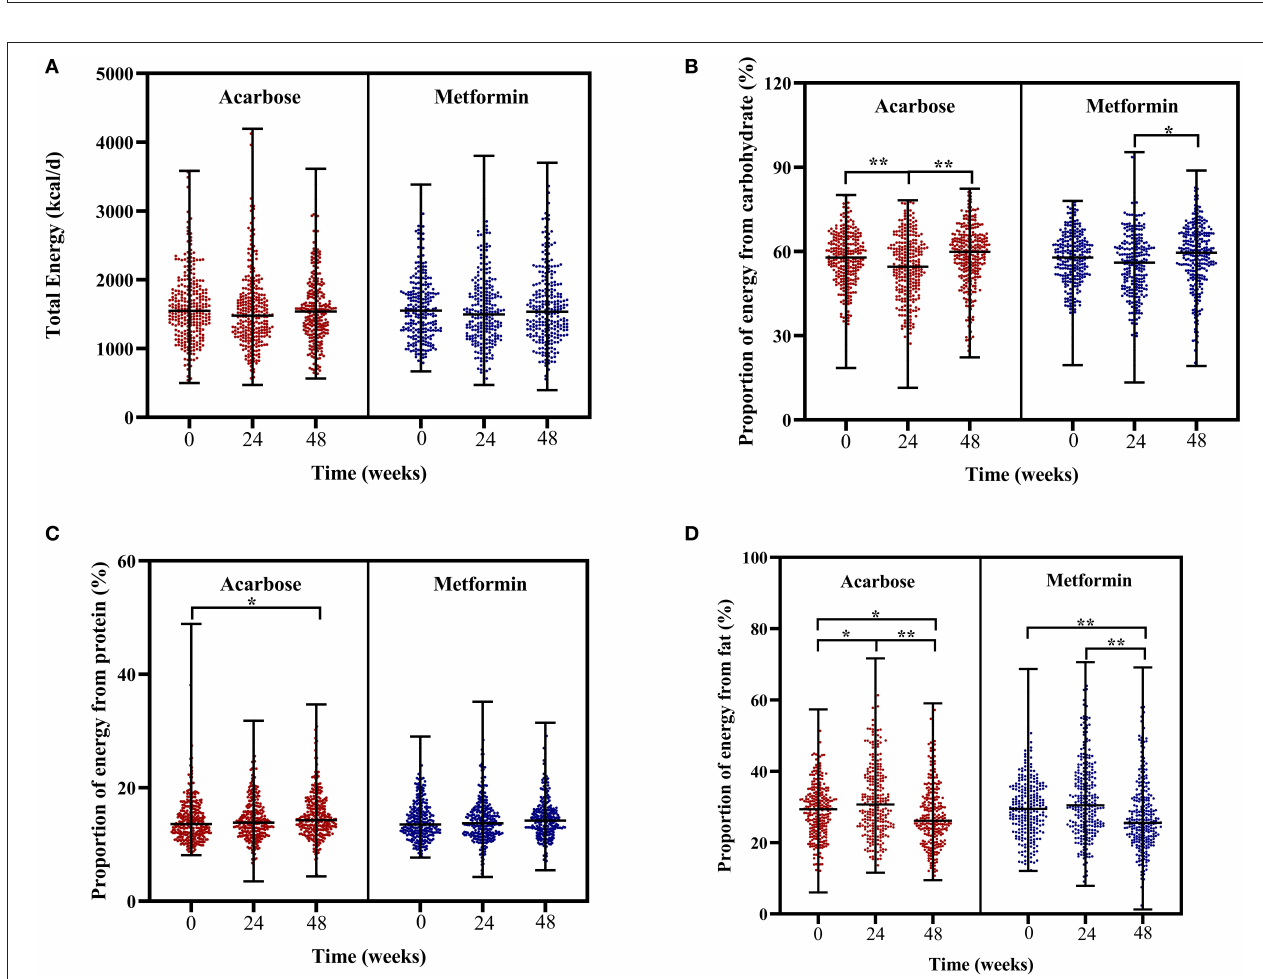
FIGURE 2 | baseline, 24 weeks, and 48 weeks. Data were tested by Friedman’s two-way analysis of variance by ranks test during three time periods (i.e., baseline, 24 weeks, and 48 weeks) in two treatment groups. * post-hoc pairwise comparison adjusted P < 0.05, ** post-hoc pairwise comparison adjusted P < 0.01. BMI, body mass index; SBP, systolic blood pressure; DBP, diastolic blood pressure; TGs, triglycerides; TC, total cholesterol; LDL-C, low-density lipoprotein cholesterol; HDL-C, high-density lipoprotein cholesterol; FBG, fasting blood glucose; 2hPPG, 2-h postprandial plasma glucose; FINS, fasting insulin; HOMA-IR, homeostasis model